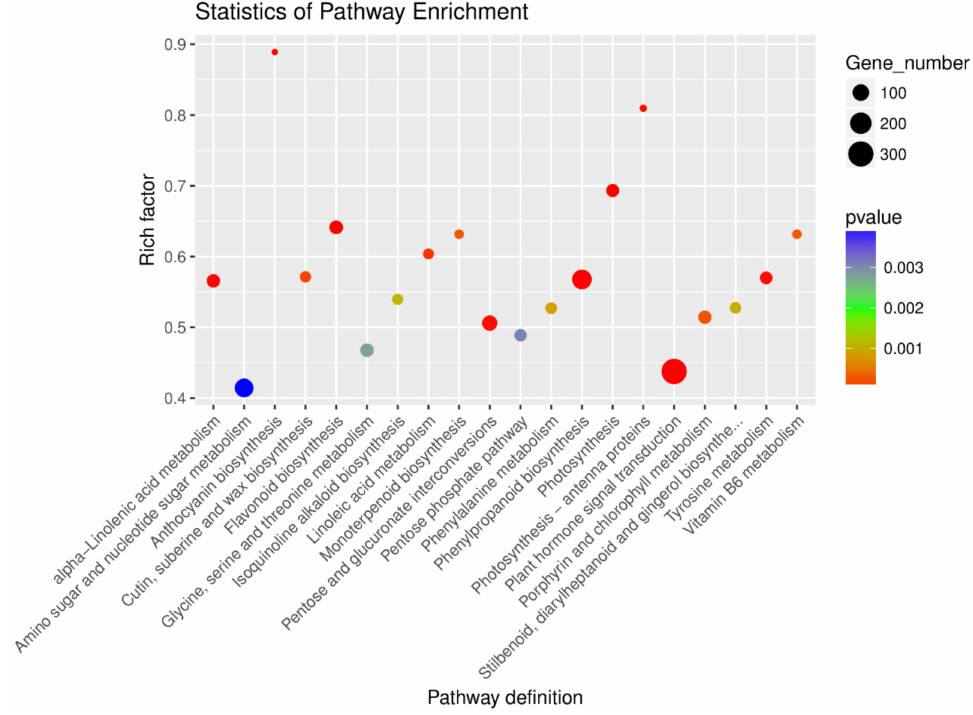
Figure 4. The top 20 of KEGG pathway enrichments in flower bud differentiation